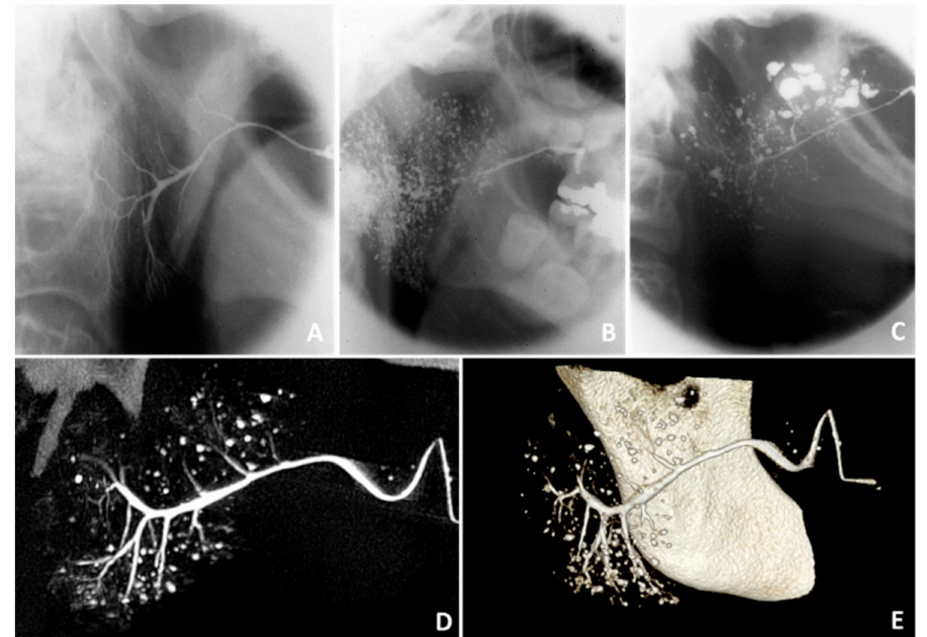
Figure 2. Findings on sialography. Sialographies of the parotid gland showing ( A ) no abnormalities in a healthy subject, ( B ) punctate / globular sialectasis in a pSS patient, and ( C ) globular / cavitary sialectasis in a pSS patient [29]. ( D ) Two-dimensional sialo-CBCT image and ( E ) three-dimensional sialo-CBCT image of the parotid gland of a pSS patient, showing normal width of the primary duct, moderate scarcity of ductal branches, and numerous diverse sialectasis. Thanks to Prof. D.J. Aframian and Dr.